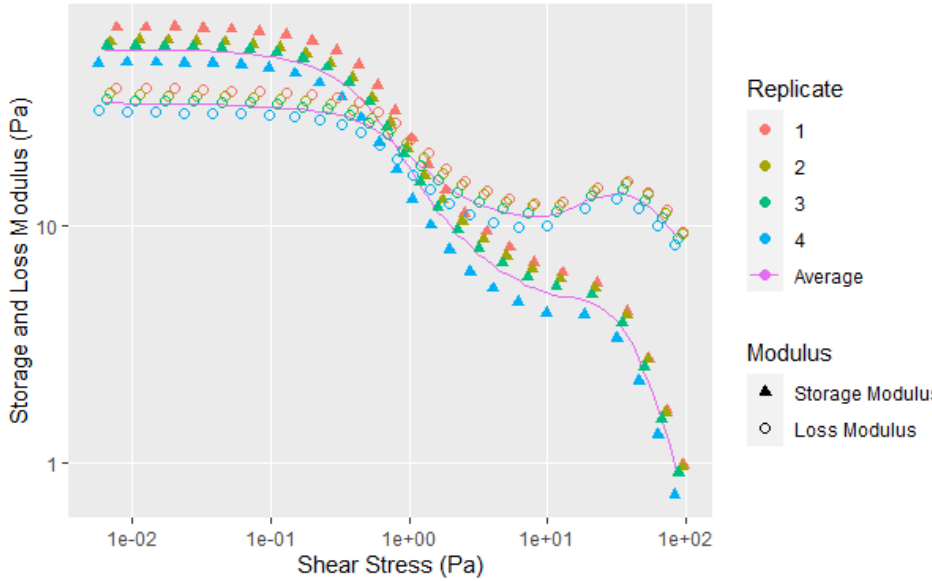
Figure A4. Individual amplitude sweep data for mixtures of 90 PDI flour with 1 h mixing time and 25% solid content.